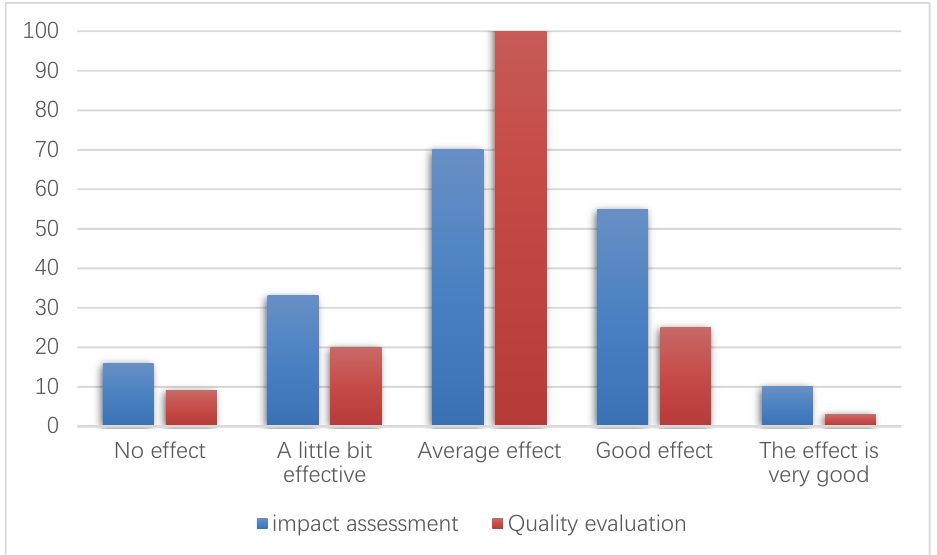
Figure 14. Frequency comparison of consumers’ quality evaluation and effect evaluation of organic agricultural products.